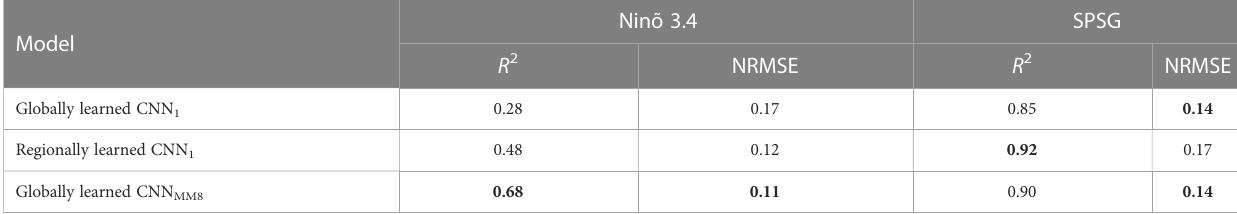
Best performances are highlighted in